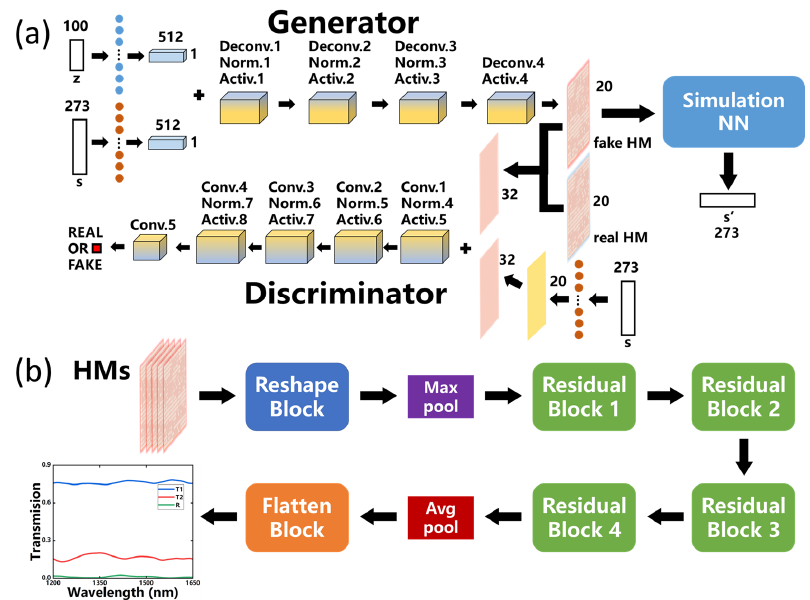
Figure 3. ( a ) The schematic diagram of WGAN-sim, where s ’ is the response of fake HM predicted by sim-NN. Here, Deconv. means the deconvolution layer, Norm. is the normalization layer, Activ. is the activation function layer, and Conv. is the convolution layer. ( b ) The flowchart of sim-NN.